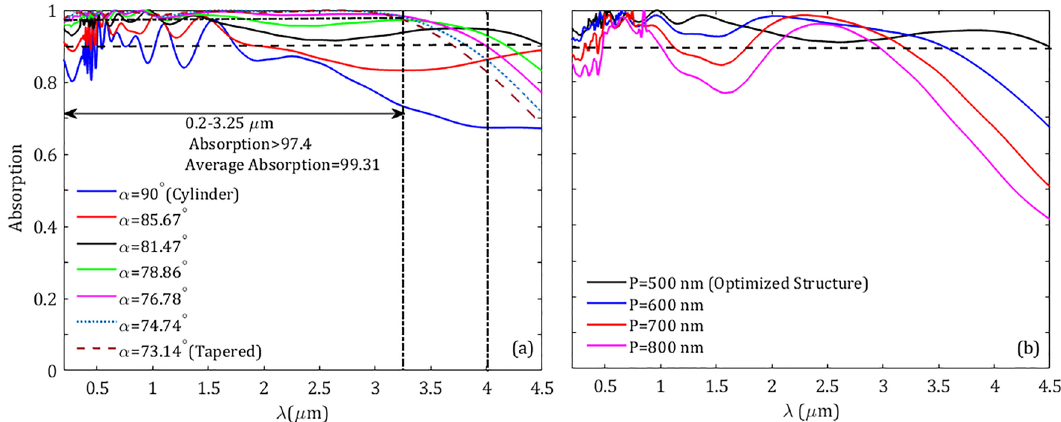
Figure 8. The absorption spectra for the designed metasurface, ( a ) varying the side angle α of the truncated cone, and ( b ) for different values of the periodicity P of arrays. The other parameters are kept constant as Fig. 3.